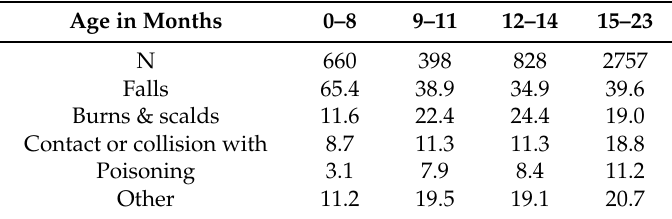
Table 2. Distribution (%) of the cause of injury in the first two years of life.